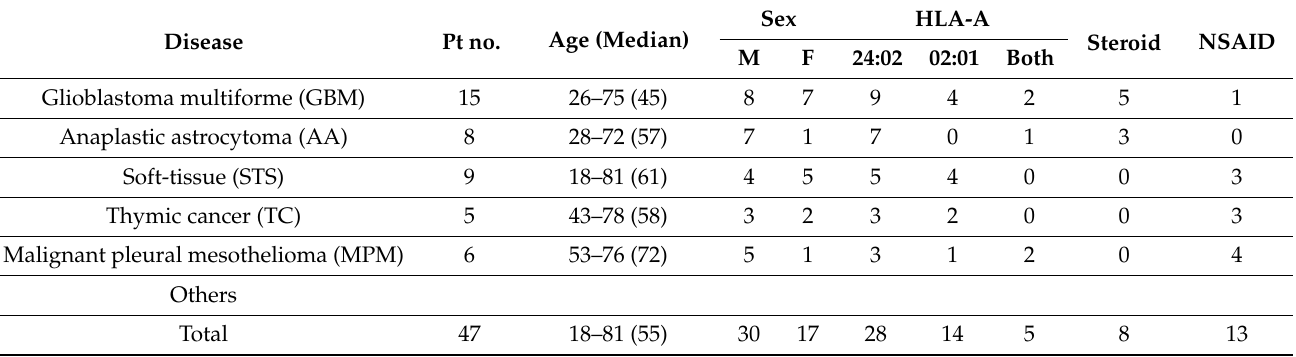
Table 1. Patient